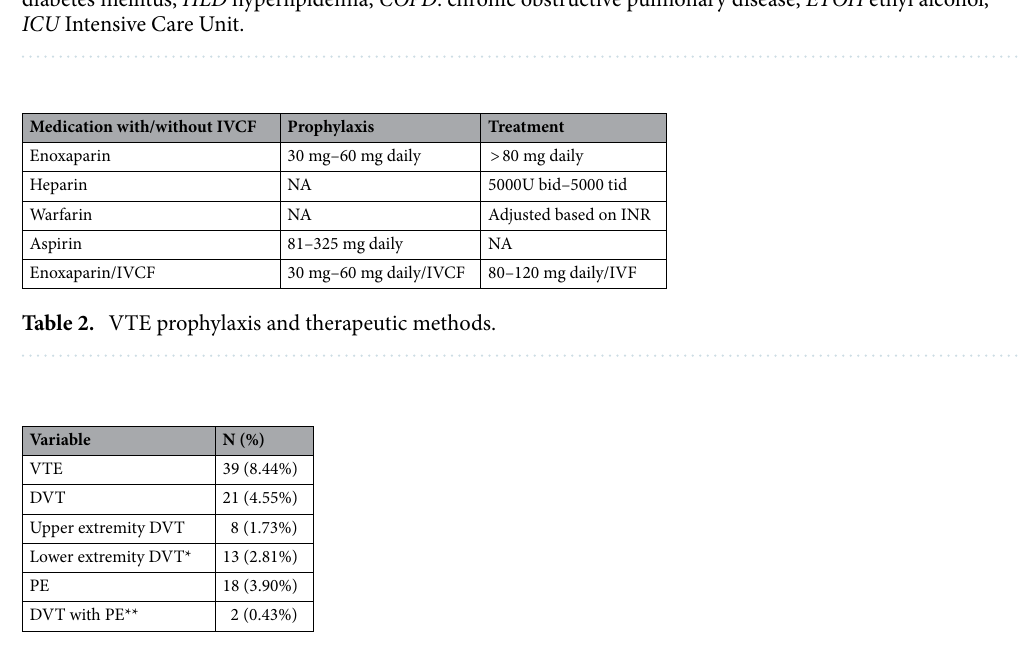
Table 1. Summary of demographic data with comparison of group with and without CIVTE. PVA pedestrian VS motor vehicle accident, MVA motor vs motor accident, GSW gunshot wound, HTN hypertension, DM